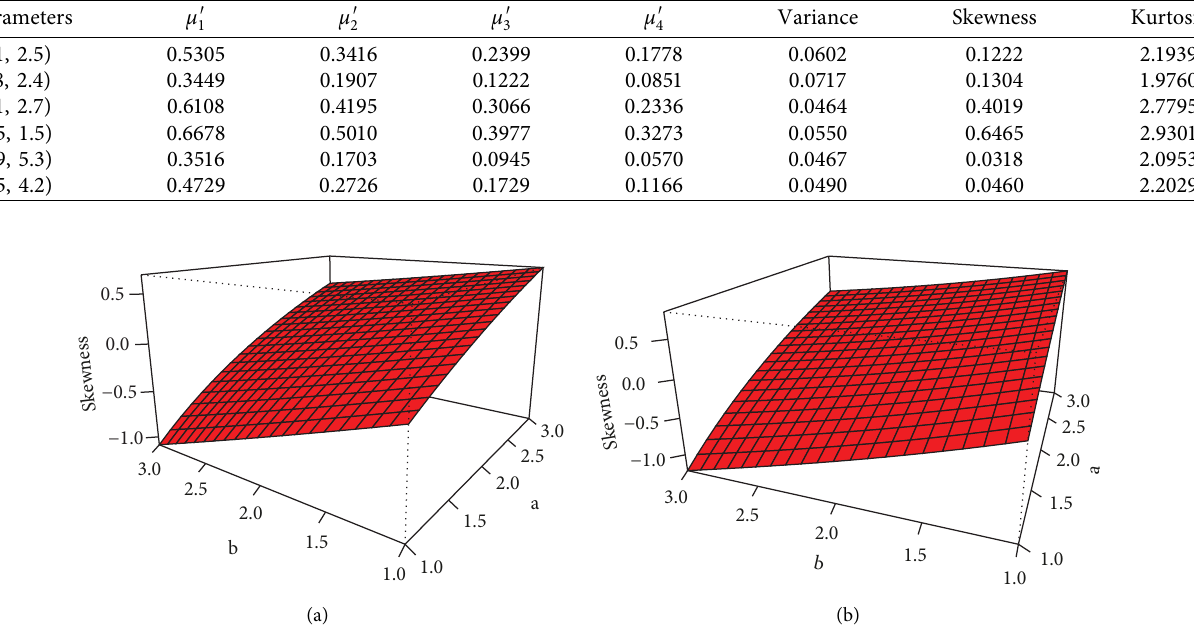
Figure 3: Plots of MKw skewness for some parametric values.